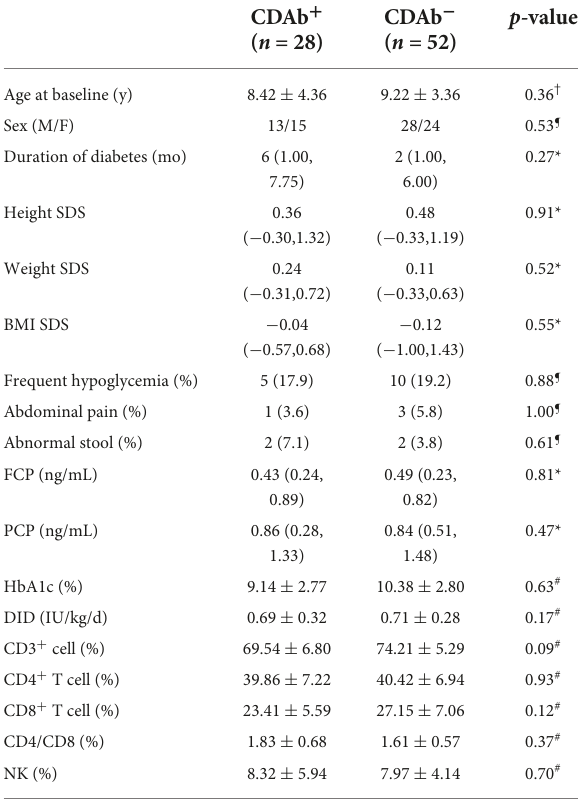
TABLE 1 Comparison of the anthropometric features of children with T1D possessing positive or negative celiac